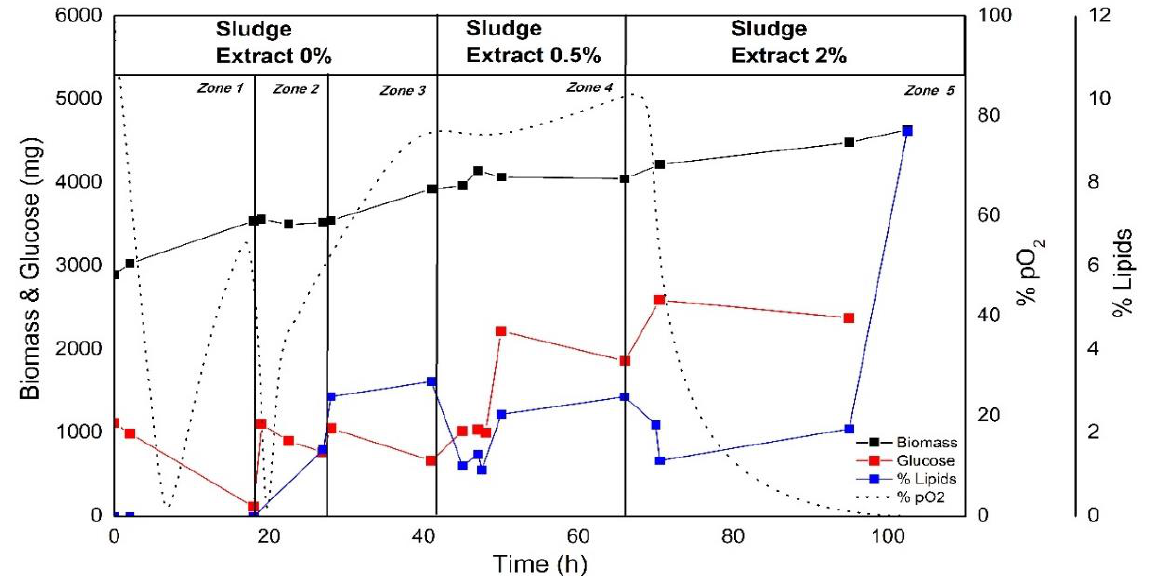
Figure 5. Lipid production, substrate consumption, and biomass formation profiles based on the addition of different proportions (0, 0.5, and 2% v/v ) of anaerobic sludge extract and a bolus feeding of glucose at different cultivation times. Each zone represents a different physiological response of C. sorokiniana under heterotrophic culture conditions.